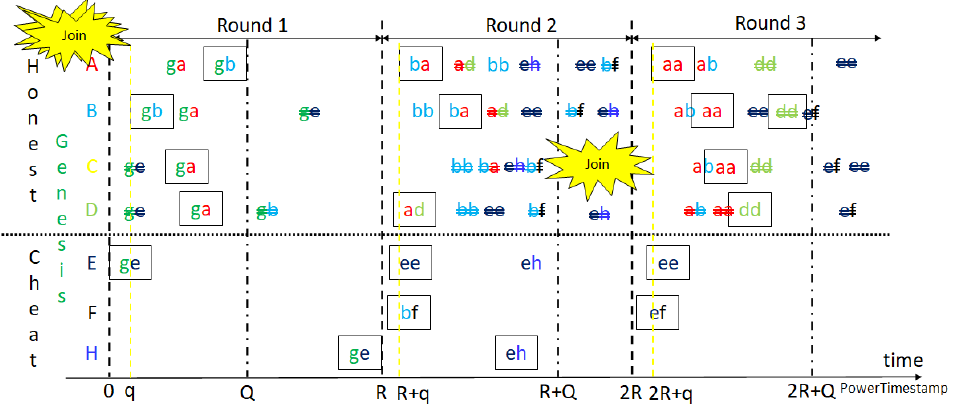
Figure 8. GPoW mining with partitions of the same